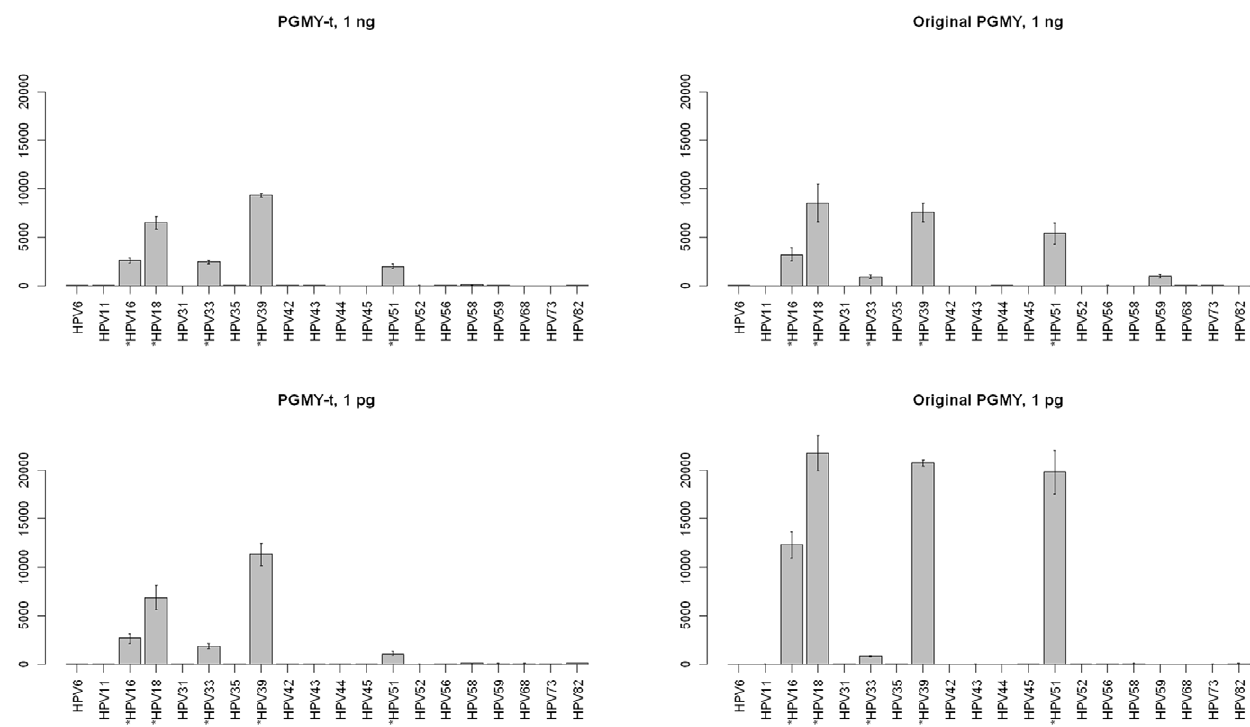
Figure 3. Comparison of the PGMY-t and the original PGMY multiplex PCR primer mixes as measured by HPV LDR signals on microarray. Both primer mixes at 0.2 m M primer concentration amplify all five HPV types from 1 ng of template (A) & (B) and from 1 pg of template (C) & (D). With the original PGMY mix at 1 ng template concentration, HPV 59 gives a false positive signal (B). HPV 33 signal is also relatively weak with the original PGMY at 1 pg template concentrations (D). Data are presented as means 6 SD from two independent microarrays. Y-axis shows signal intensity in arbitrary units. Asterisk (*) indicates the target HPV types present in the experiment.